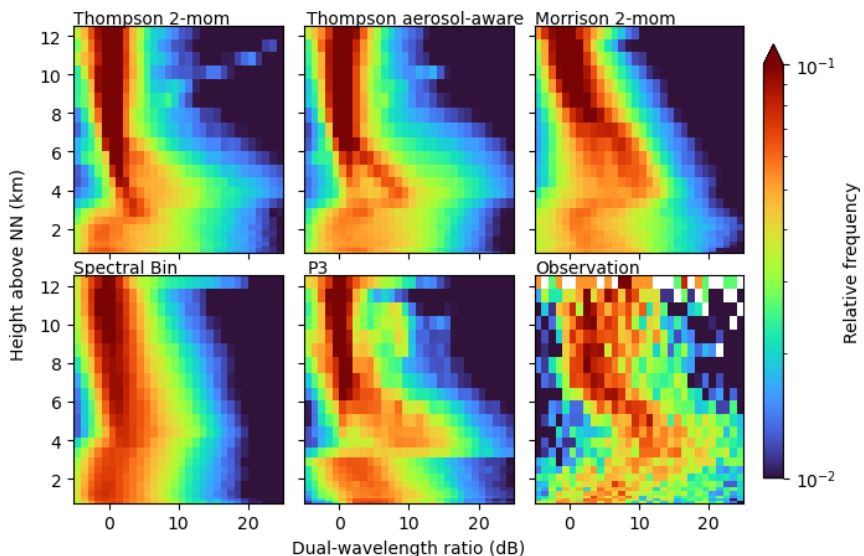
Figure 7. CFADs of simulated and measured DWR over 5 convective days in 2019. Radar observations with Poldirad and Mira35.